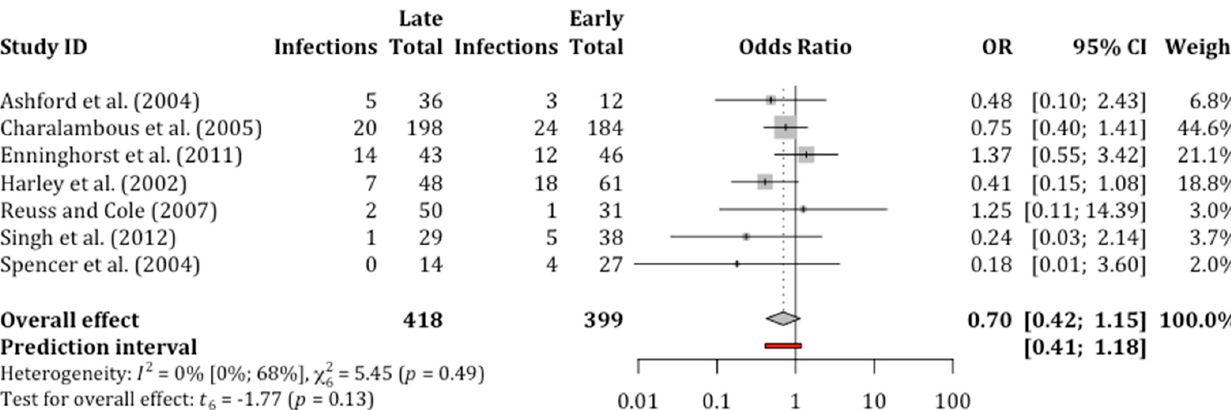
Figure 3. Forest plot of random effects meta-analysis comparing the incidence of non-union after late surgical debridement compared to early debridement in open tibial fractures. OR = odds ratio; CI = confidence interval.